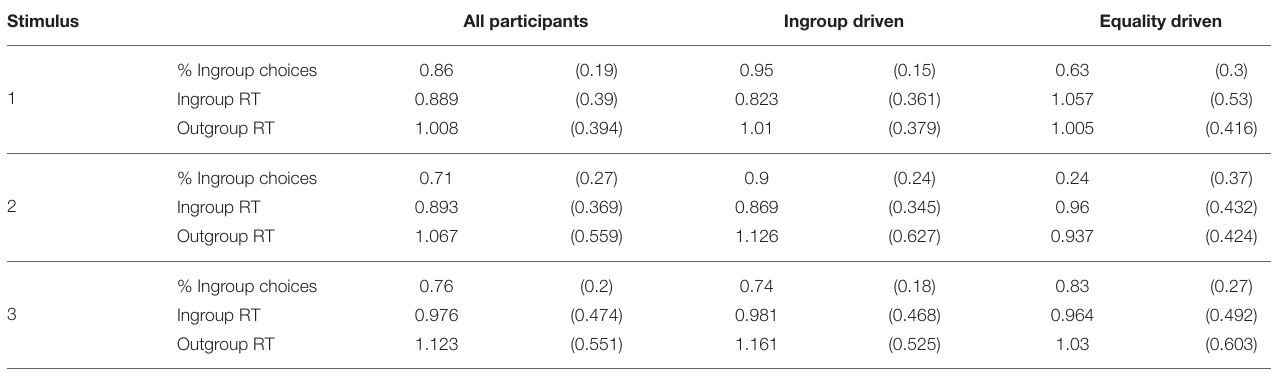
TABLE 1 | Behavioral data— all participants vs. ingroup driven vs. equality driven . Stimulus All participants Ingroup driven Equality driven % Ingroup choices 1